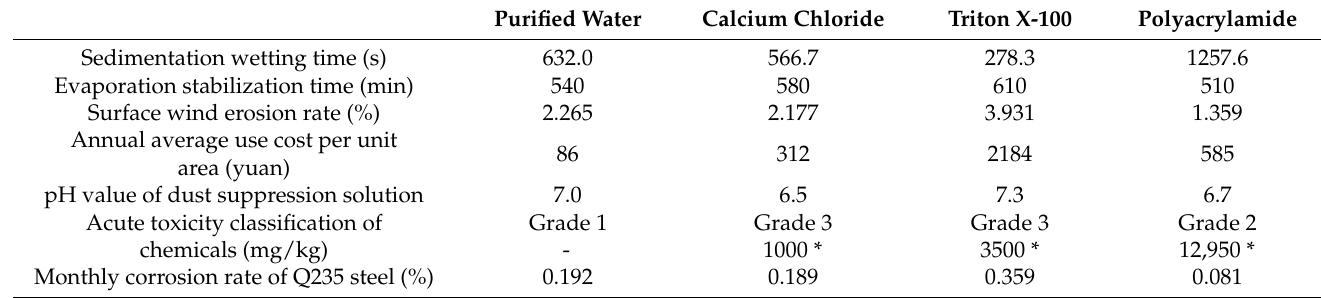
Table 3. Evaluation parameter data of several chemical materials for dust suppression. Purified